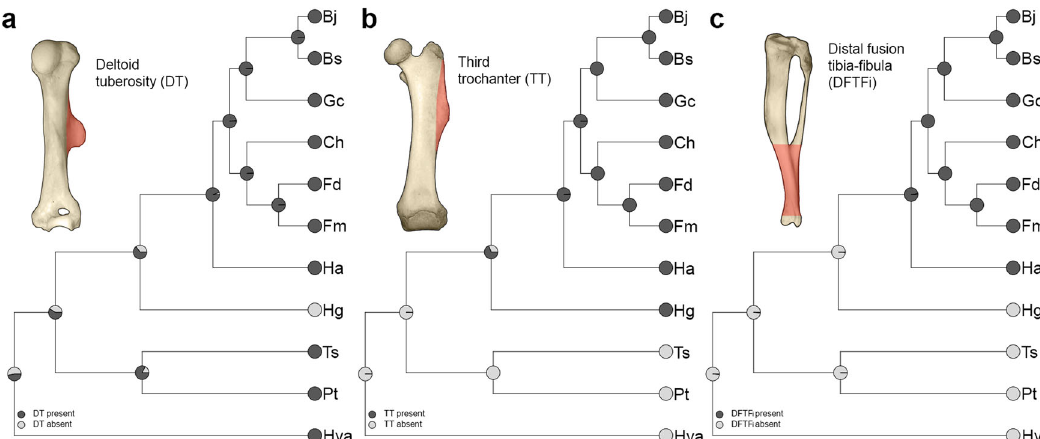
Fig. 5 Ancestral state reconstructions of discrete bone superstructures in Bathyergidae and the outgroups Petromuridae, Thryonomyidae, and Hystricidae. a Deltoid tuberosity (DT); b third trochanter (TT); and c distal fusion of the tibia- fi bula (DFTFi). Values at internal nodes were obtained by simulating character maps over the posterior sample of 1000 trees, using a method of stochastic character mapping. Simulated values are interpreted in terms of posterior probability. Bone illustrations show the analysed bone superstructure (red area). Bs Bathyergus suillus , Bj Bathyergus janetta , Ch Cryptomys hottentotus , Fd Fukomys damarensis , Fm Fukomys mechowii , Gc Georychus capensis , Ha Heliophobius argenteocinereus , Hg Heterocephalus glaber , Hya Hystrix africaeaustralis , Pt Petromus typicus , Ts Thryonomys swinderianus . Phylogenetic relationships obtained from www.vertlife.org 79